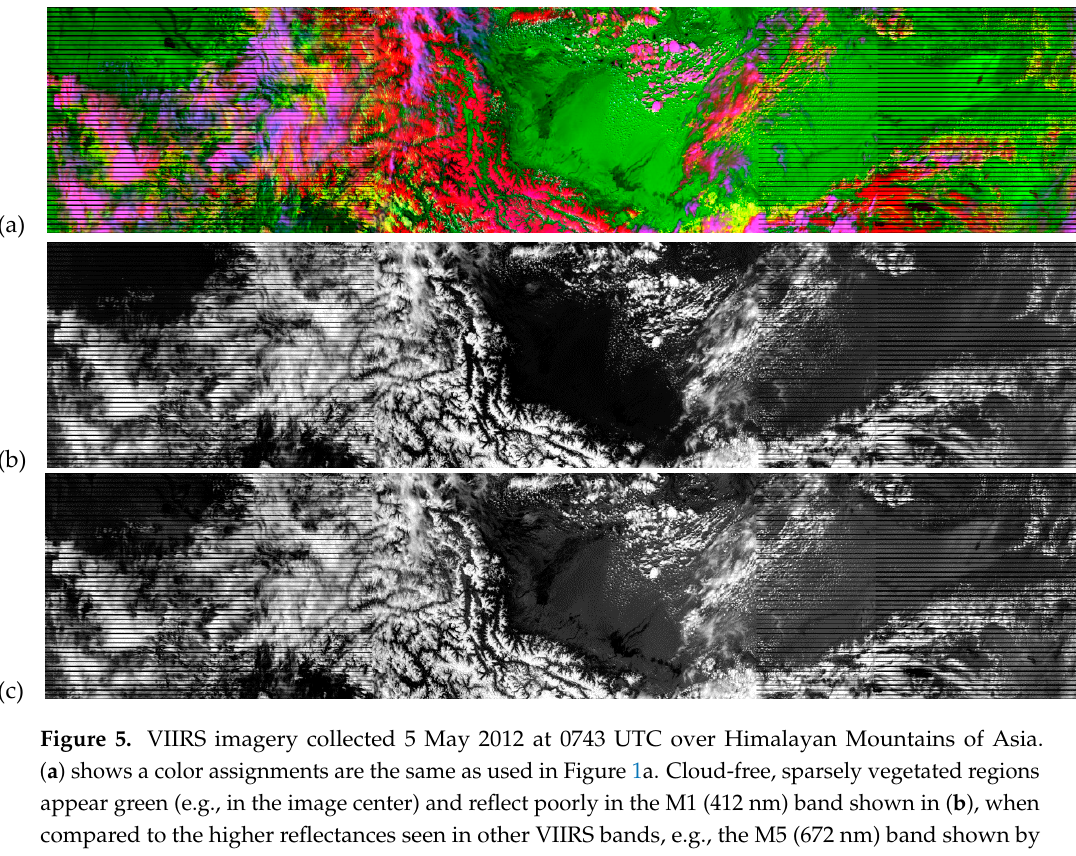
Figure 4. VIIRS imagery collected on 17 January 2013 at 1714 UTC over coastal Argentina and South America. Figure 4 a contains a false color composite from M5 (672 nm), M10 (1610 nm), and M16 (12013